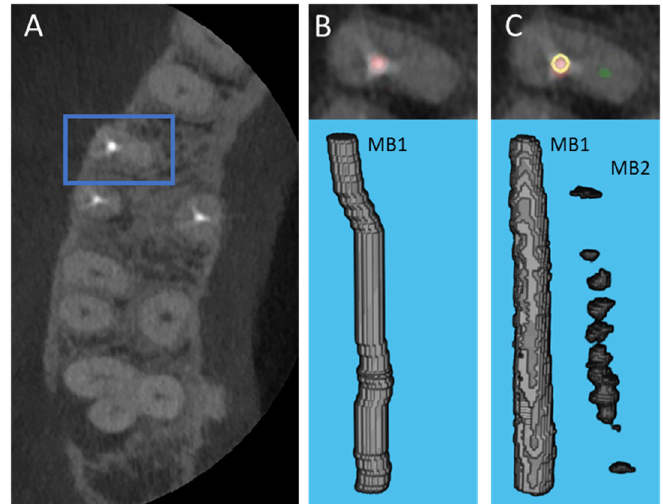
Figure 4. Case where U-Net performed better than the manual segmentation; an unobturated MB2 canal was present, yet the resident had difficulty segmenting the canal. ( A ) CBCT axial cross section view showing the location of the root, blue box indicates the root; ( B ) Manually generated segmentation visualized in the CBCT axial cross section (top) and the corresponding 3D view (bottom), the red color depicts the superimposed obturated MB1 canal; ( C ) U-Net generated segmentation visualized in the CBCT axial cross section (top) and the corresponding 3D view (bottom), the U-Net generated canal segmentation is red for the obturated MB1 canal and green for the unobturated MB2 canal, the yellow ring represents the location of manual segmentation relative to U-Net generated segmentation.